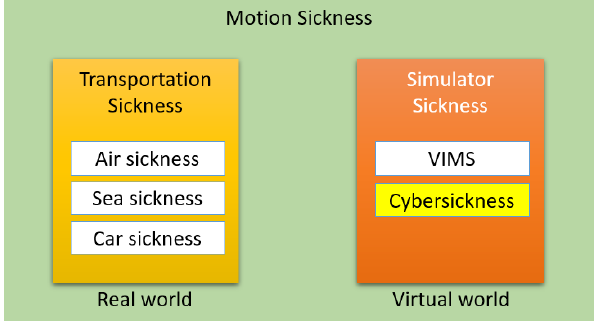
Figure 2. Motion sickness and its subcategories according to environments and trigger